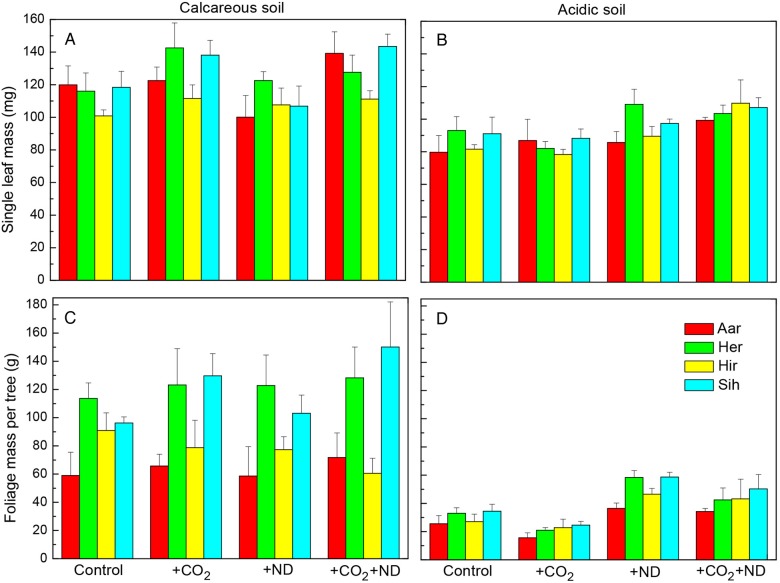
The change in the dry mass of single leaves (A and B) and total crown foliage (C and D) in beech in response to +CO2, +ND and +CO2 + ND versus control for several origins (Aar, Aarburg; Her, Herzogenbuchsee; Hir, Hirschtal; Sih, Sihlwald) growing together on either acidic or calcareous forest soil (mean values + SE, N = 4, September harvest).